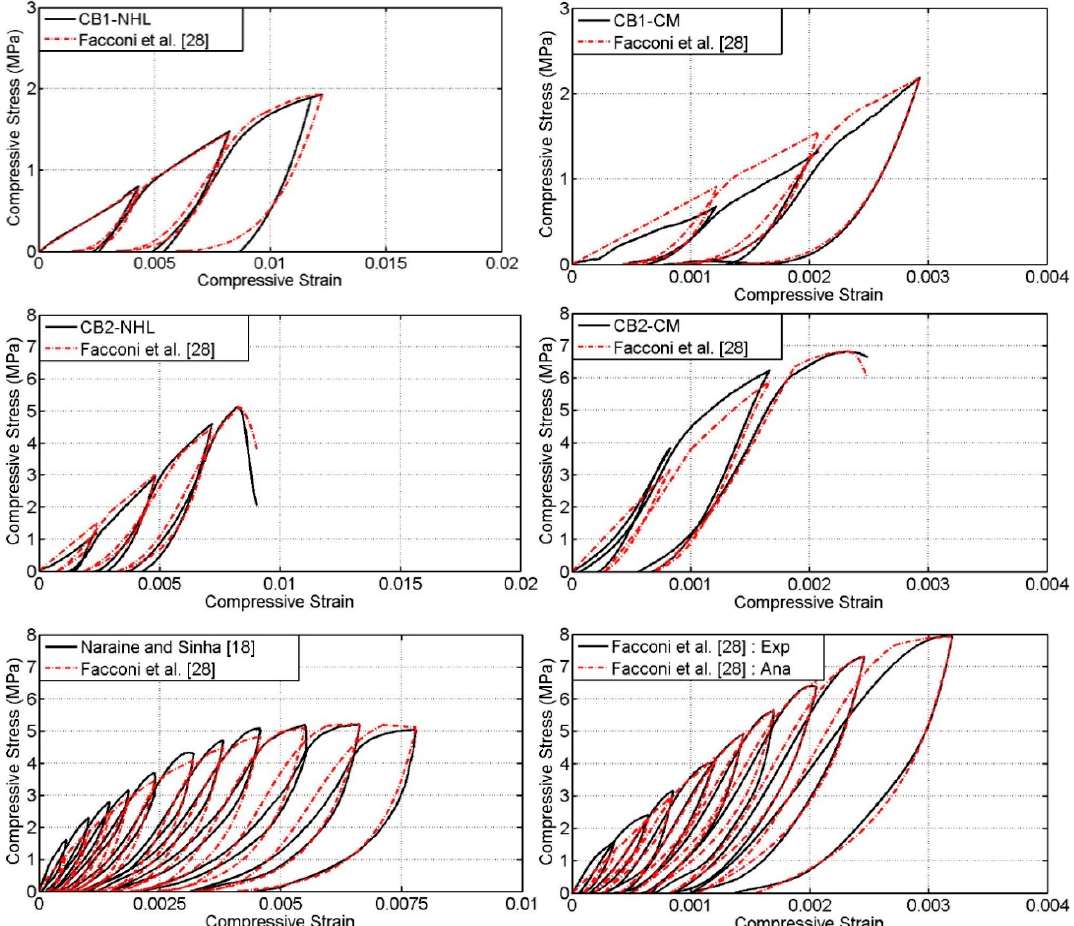
Figure 8. Comparison of experimental cyclic stress–strain curves with analytical curves of Facconi et Figure al. [28].